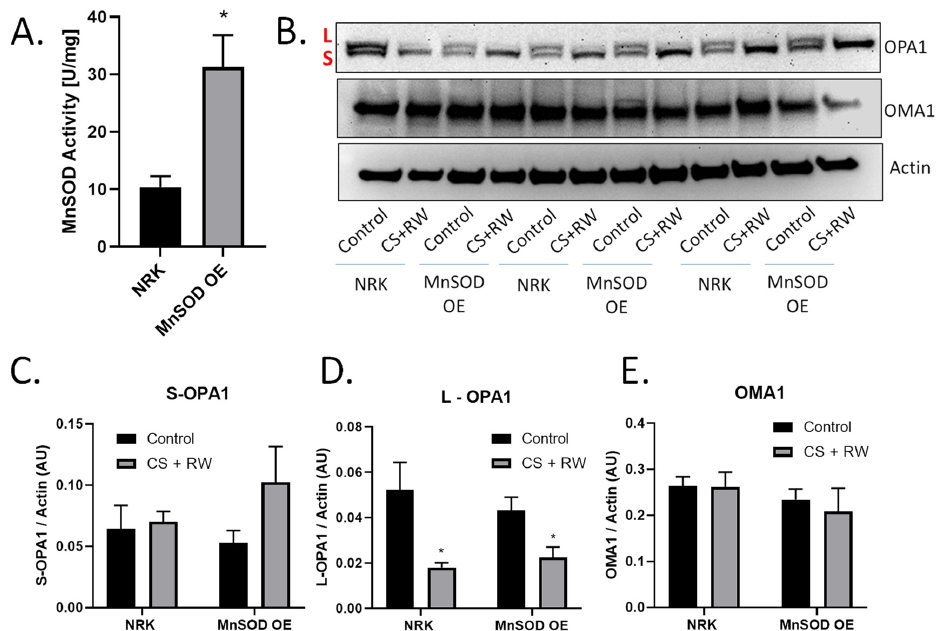
Figure 4. Overexpressing MnSOD did not prevent CS + RW-induced OPA1 proteolytic processing. ( A ) MnSOD activity assay utilizing cytochrome C reduction showed a threefold increase in MnSOD activity in NRK cells stably overexpressing MnSOD (MnSOD OE) compared to control/untransfected NRK cells. ( B ) Representative western blot of OPA1, OMA1, and actin (loading control) from control or CS+RW treated NRK cells and NRK cells overexpressing MnSOD. ( C – E ) Densitometry values were normalized to actin (~40 kDa) and expressed as mean density ±SEM (bars; arbitrary units). Data were evaluated using unpaired student t-test, * p < 0.05, n = 3 separate experiments. Abbreviations: AU—arbitrary units,